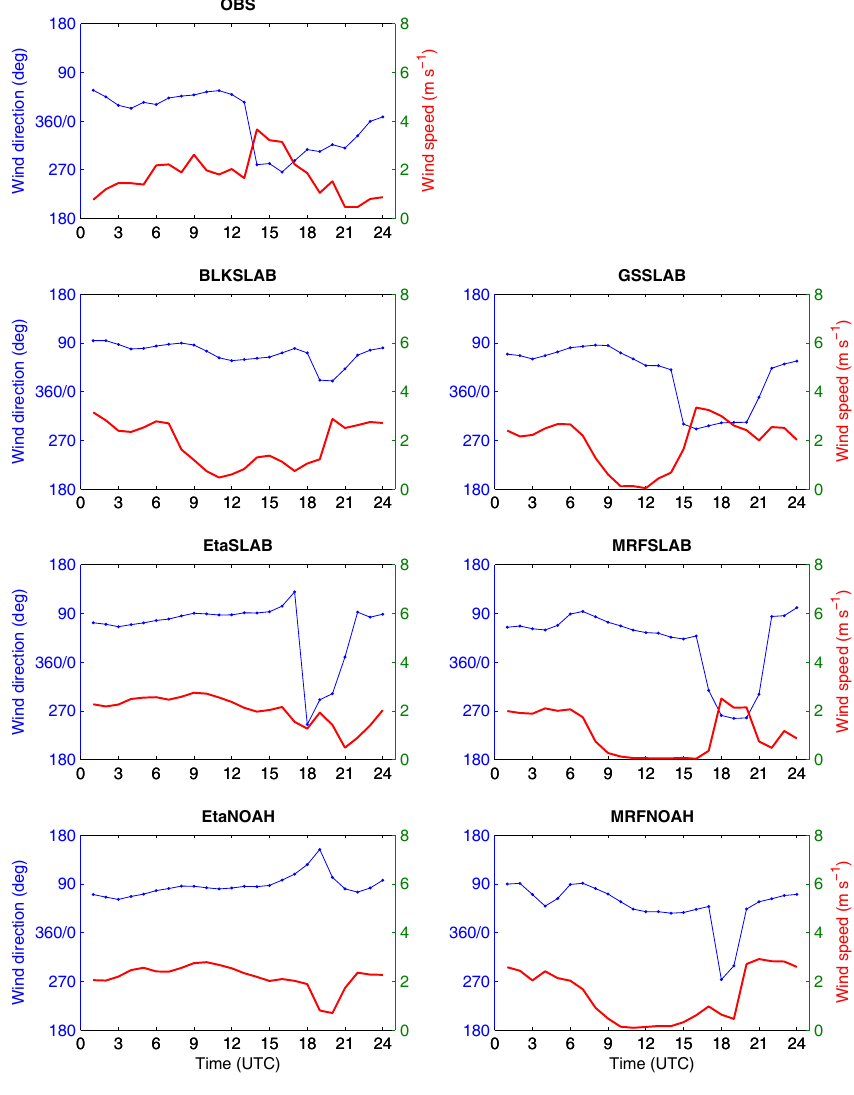
Fig. 7. Same as Fig. 2 but at Lejonet